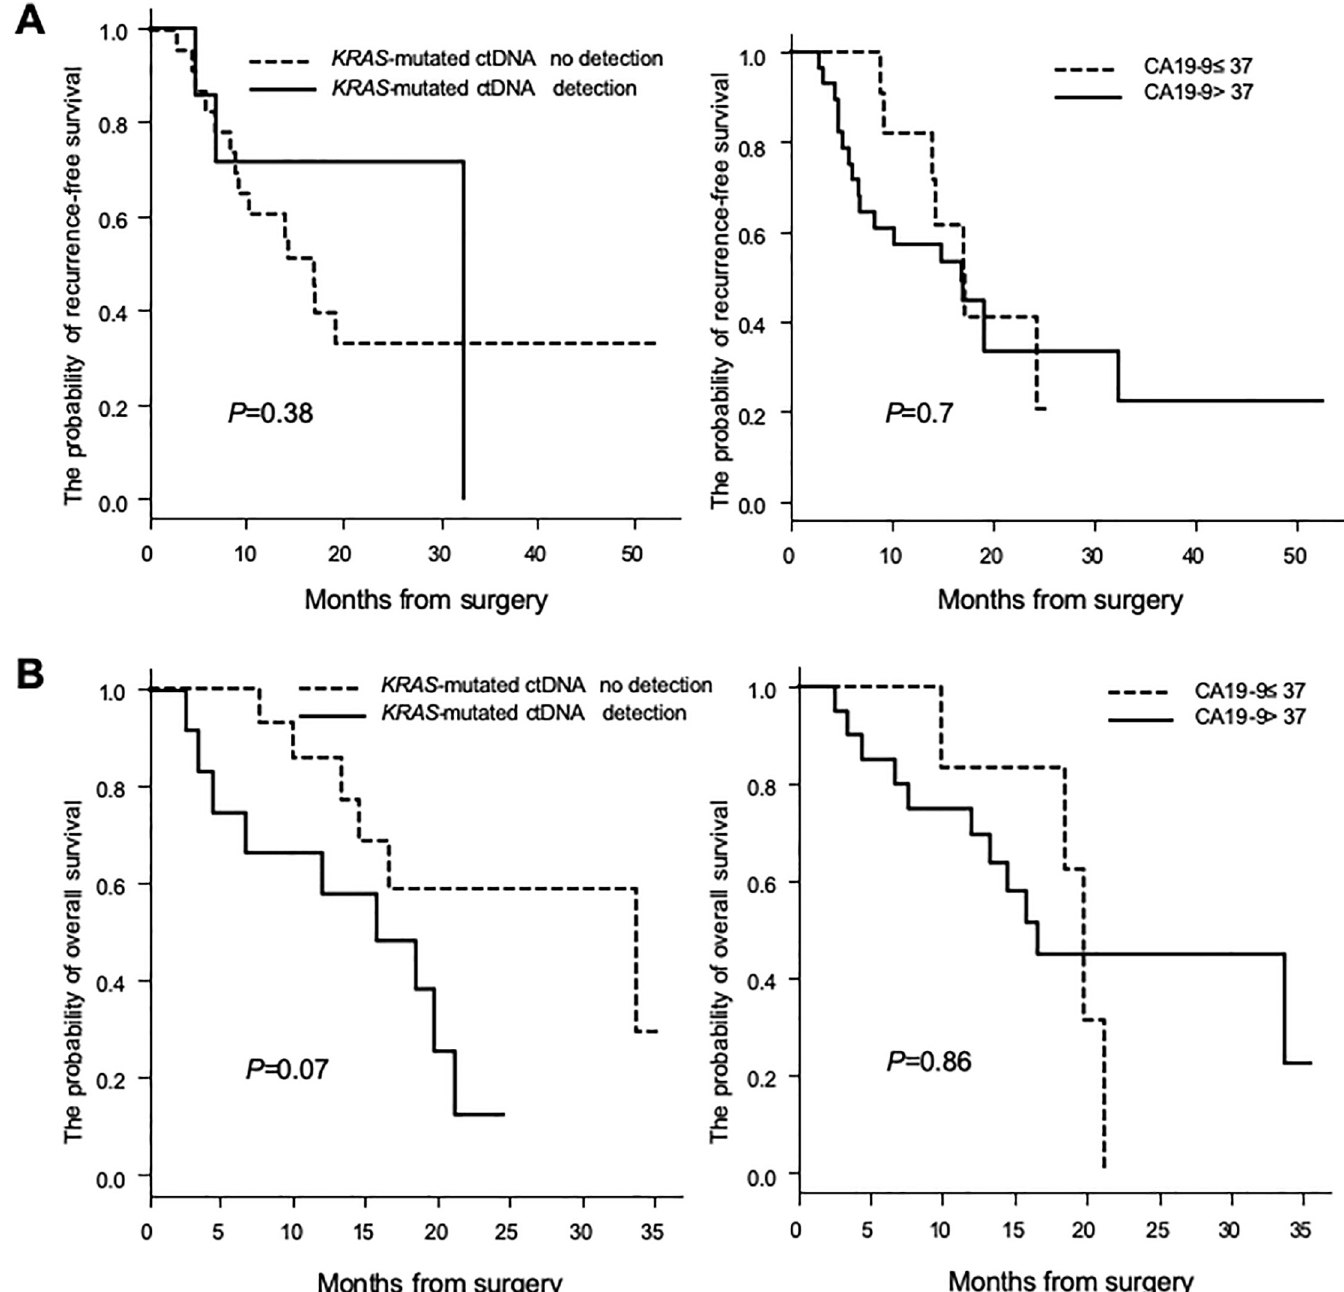
Fig 1. One-point assessment of ctDNA and carbohydrate antigen 19–9 (CA19-9) before treatment to assess recurrence and prognosis. (A) Recurrence-free survival (RFS) curves according to the presence of KRAS- mutated ctDNA and CA19-9 level before surgery in 39 patients who underwent surgery ( P = 0.38 and 0.7 by log-rank test). (B) Overall survival (OS) curves according to the presence of KRAS- mutated ctDNA and CA19-9 level before first-line chemotherapy in 26 chemotherapy-na ï ve patients who did not undergo surgery ( P = 0.07 and 0.86 by log-rank test). X-axes indicate the months from surgery, whereas Y-axes indicate the probability of RFS or